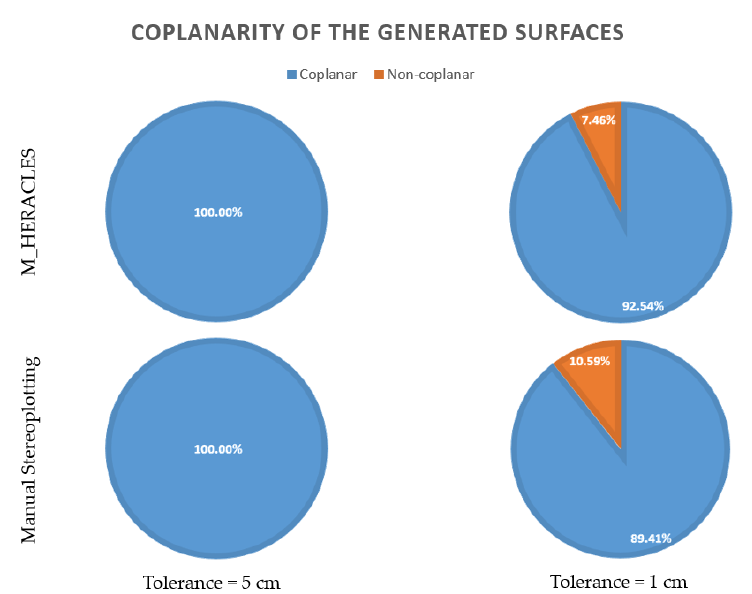
Figure 10. Coplanarity check for each set of vertices constituting the roof surfaces, with a tolerance of 5 cm ( left ) and 1 cm ( right ). The same parameters for roof surfaces generated by manual 3D stereoplotting are also given on the lower row as a comparison. Note that the original point cloud’s resolution is 10